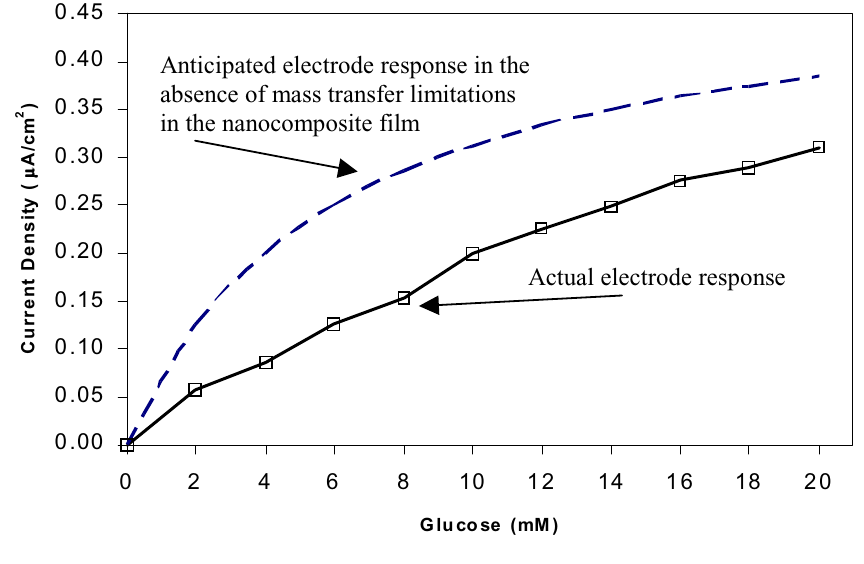
Figure 5. Concentration dependence of the electrode current density for a nanocomposite thin film comprised of two RP/GOX